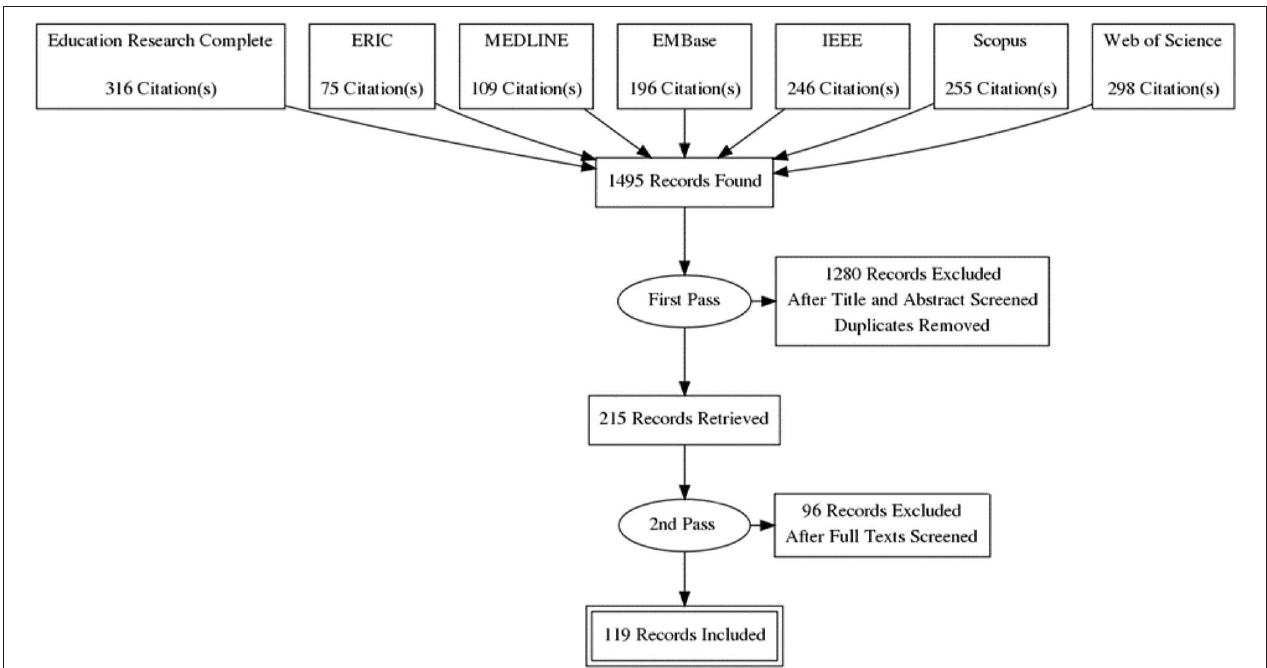
FIGURE 1 | PRISMA flow diagram of search results.